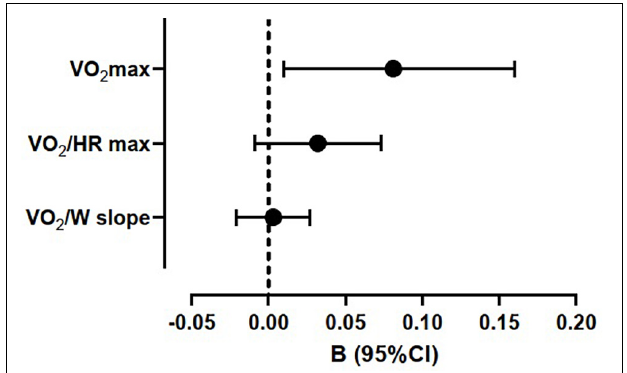
FIGURE 2 | Regression coefficients of maximum oxygen uptake (VO 2 max), maximum oxygen pulse (VO 2 /HR max), and work efficiency (VO 2 /W slope) with average weekly physical activity (METs h − 1 · week − 1 ) at multiple linear regressions. The models were adjusted for sex, body mass index, forced expiratory volume in first second of expiration (% predicted), diagnosis of pectus excavatum, and physical activity (METs h − 1 · week − 1